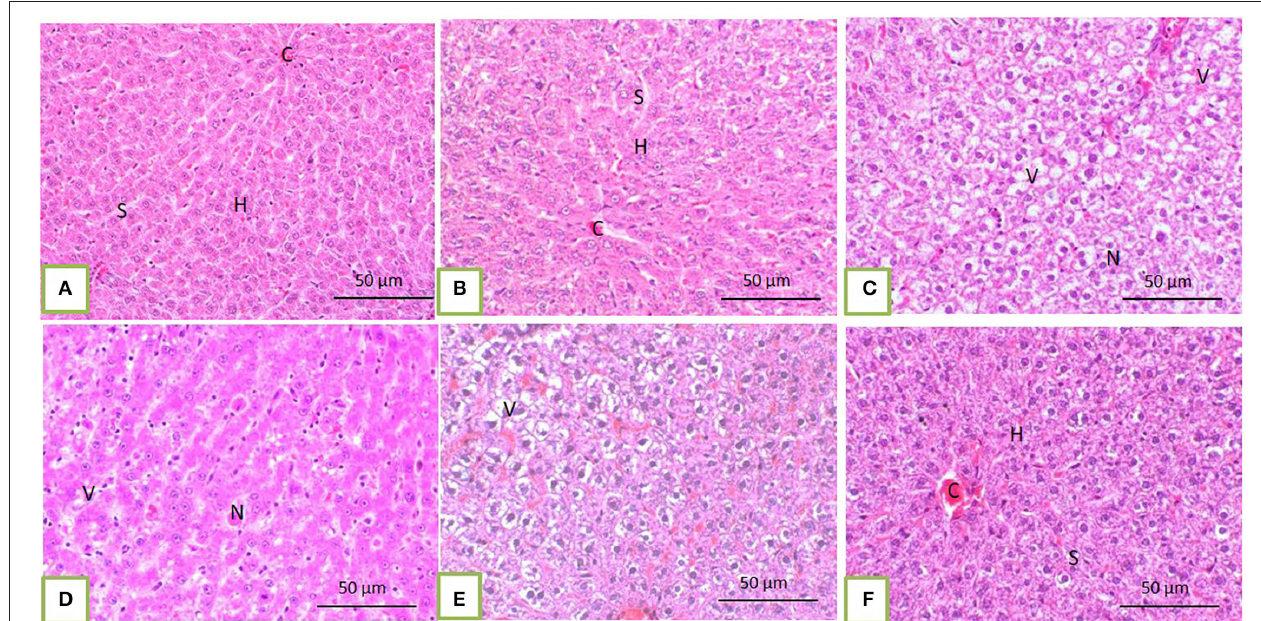
FIGURE 3 | The liver of control rats and those treated with 100, 200, and 300 mg/kg BW bLf showed a normal pattern of hepatic lobule with a centrally located vein (C) and arrangement of hepatocytes (H) in cords separated from each other by hepatic sinusoids [S; (A) and (B) ]. In rats treated with Bz alone, the liver showed marked vacuolation of hepatocytes (V) and focal hepatocytic necrosis [N; (C) and (D) ]. In rats treated with Bz + 100 and 200 mg/kg BW bLf, the liver showed slight cytoplasmic vacuolation (E) . However, in rats treated with Bz + 300 mg/kg BW bLf, the liver showed the same morphology as the control group (F)